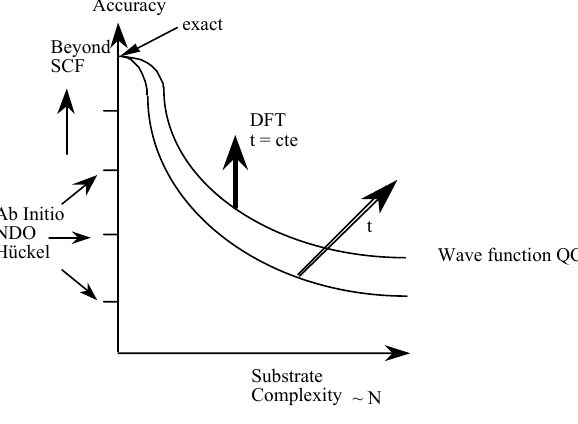
Figure 1: Accuracy versus complexity chart of Quantum Chemistry (After J.A.Pople) A central paradigm in Quantum Chemistry is the Structure-Properties-Wave function